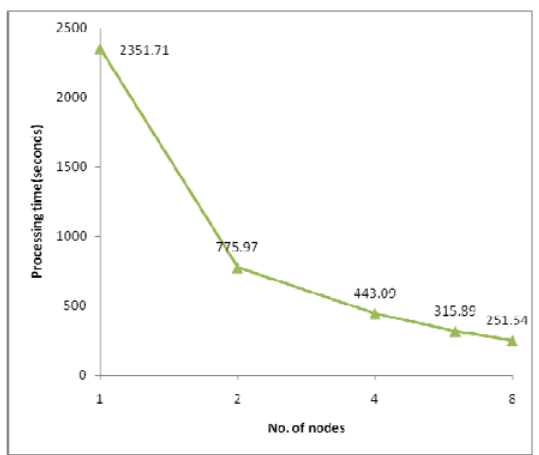
Figure 10. Processing time for dataset 4.